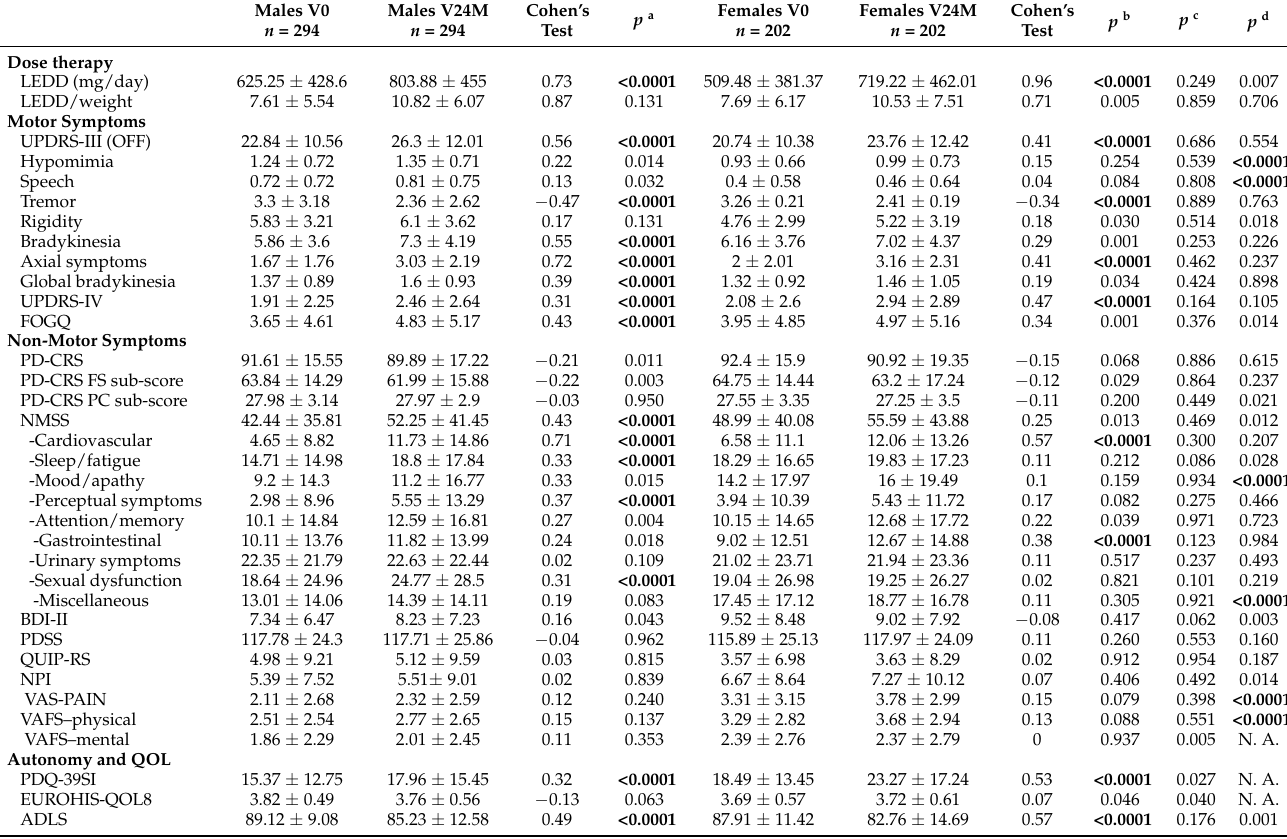
Table 4. Changes from the baseline visit (V0) to the two-year follow-up visit (V24M) in different PD-related variables in PD patients from the COPPADIS cohort regarding sex ( n =